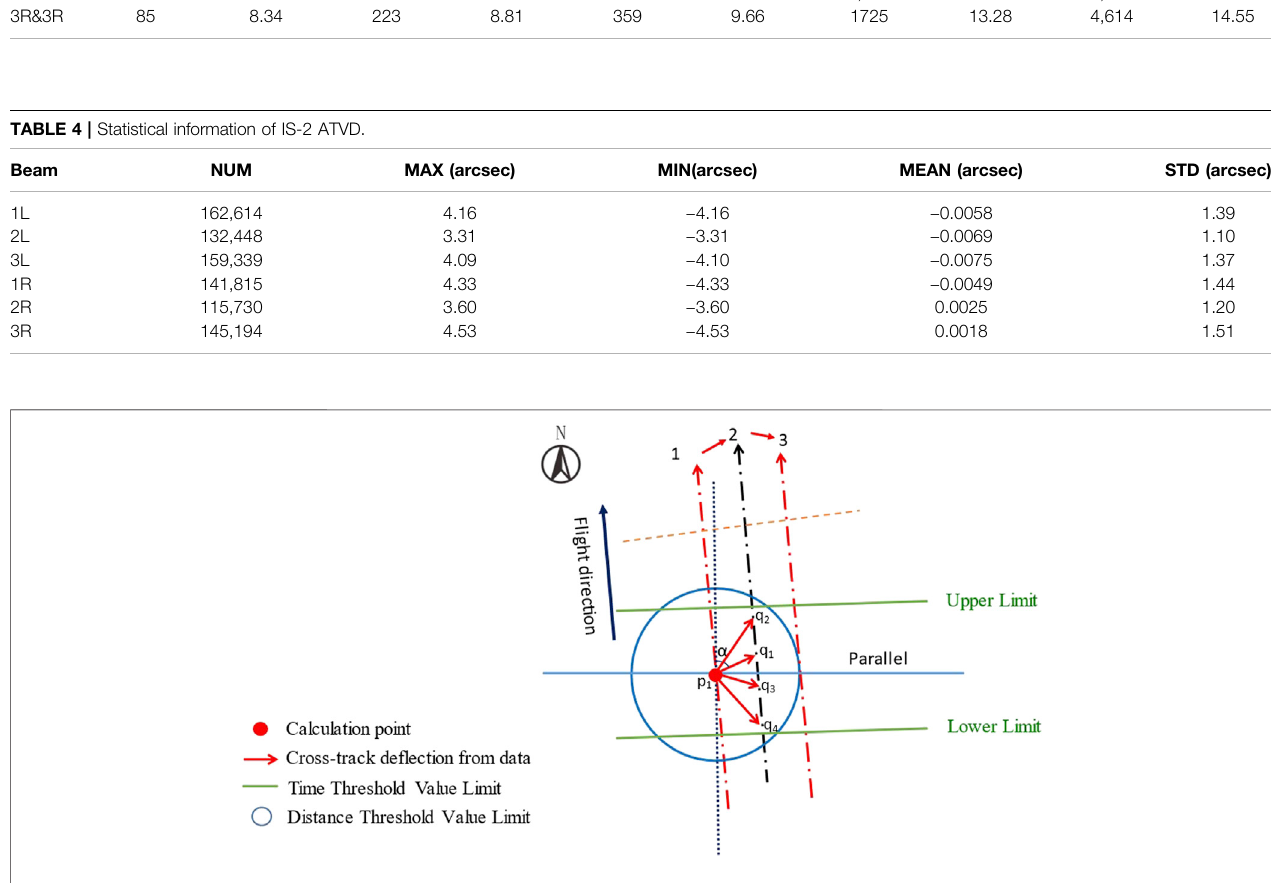
FIGURE 3 | Calculation of the